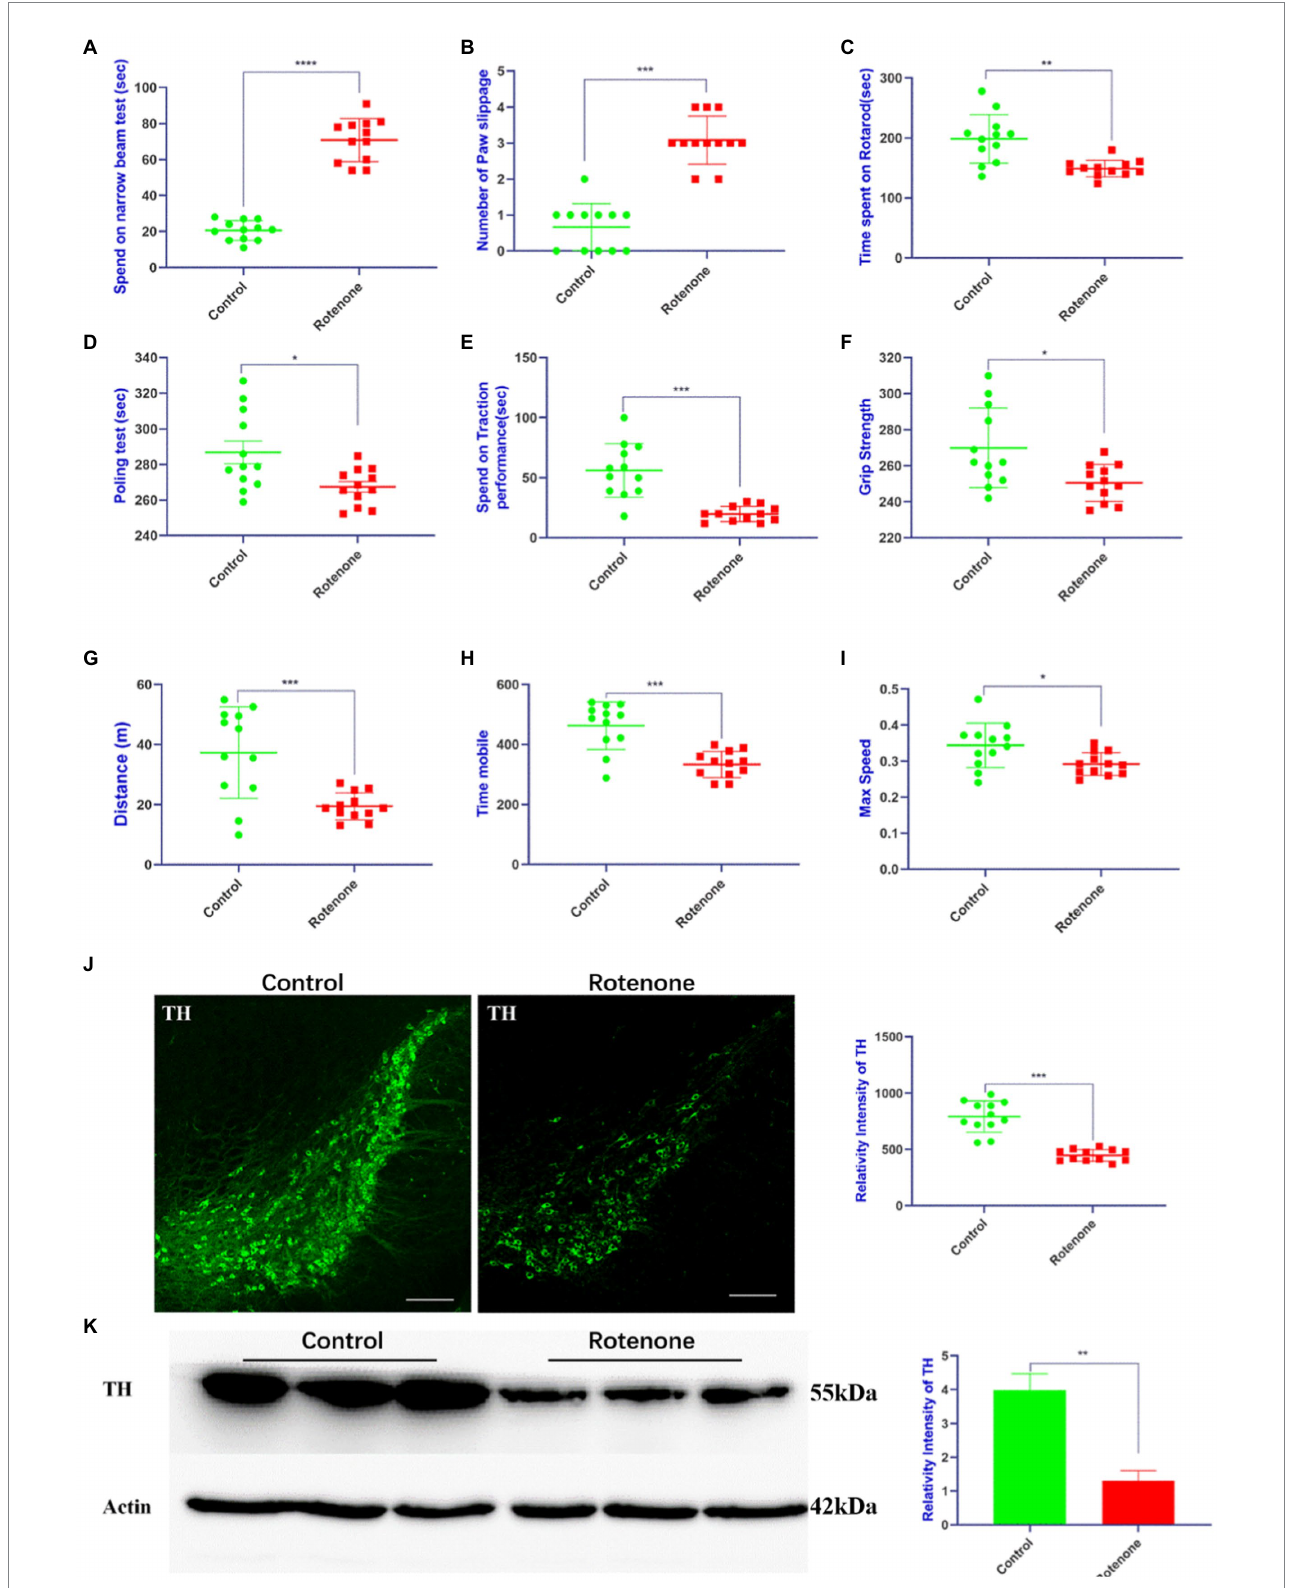
FIGURE 1 Rotenone induces motor deficits and DA neuron degeneration in rats. (A,B) Narrow beam walk test, (C) rotarod test, (D) pole test, (E) traction test, (F) grip strength test, and (G–I) open field test was performed at 28 days after rotenone/vehicle treatment through stereotaxic (ST) striatum injections ( n = 12). (J) Left panel is visualized at ×5 magnification of TH-positive cells in the SNpc of rats stained using a TH antibody; right panel is the quantitative analysis of TH-positive cells in the SNpc. (K) Left panel is the Western blotting of midbrains separated from rats performed by a TH antibody and right panel is quantitative analysis of TH intensity. For all quantitative/statistical analysis, * p < 0.05; ** p < 0.01; *** p < 0.001 and **** p < 0.0001. All data are presented as means ± SEMs. Scale bars are 250 μ m in (J) . DA, dopaminergic; TH, tyrosine hydroxylase; SNpc, substantia nigra pars